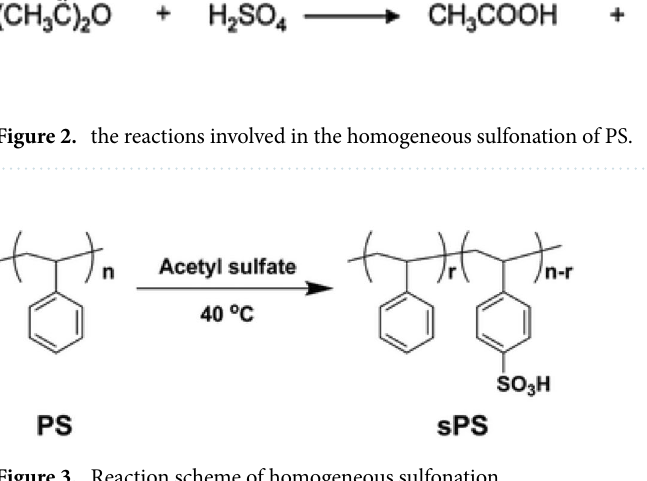
Figure 3. Reaction scheme of homogeneous sulfonation.